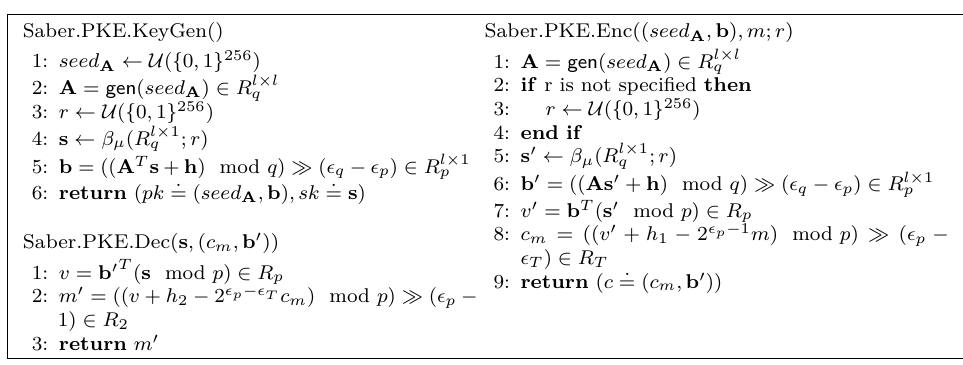
Figure 1: Description of Saber.PKE from [D + 20].